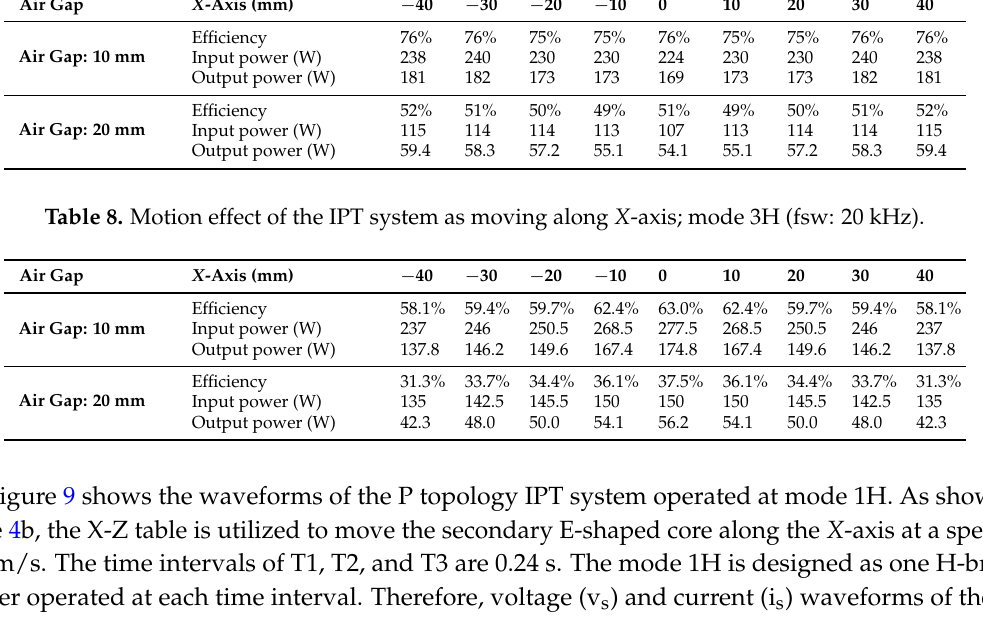
Table 7. Motion effect of the IPT system as moving along X ‐ axis; mode 2H (fsw: 20 kHz). Air Gap